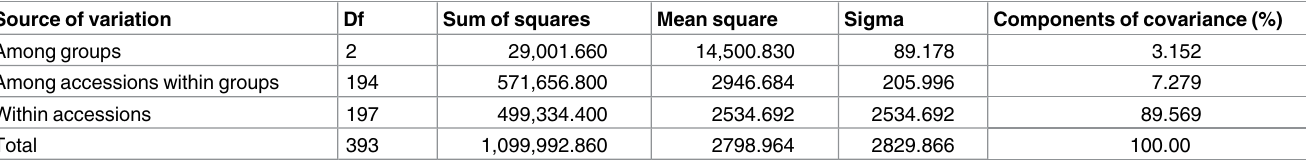
Table 6. Comparison of percent of alleles generated in the total collection v ersus the core set. Total collection (197 acc.) Core set (39